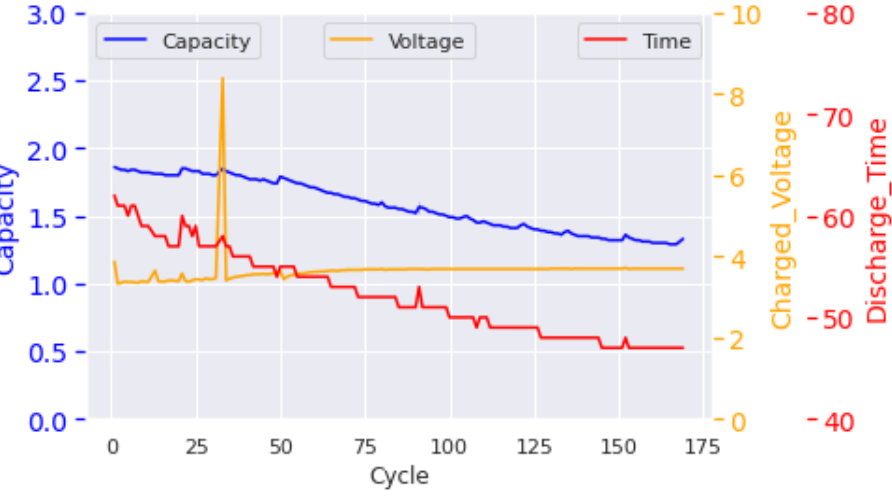
Figure 5. Discharge profile in capacity change.